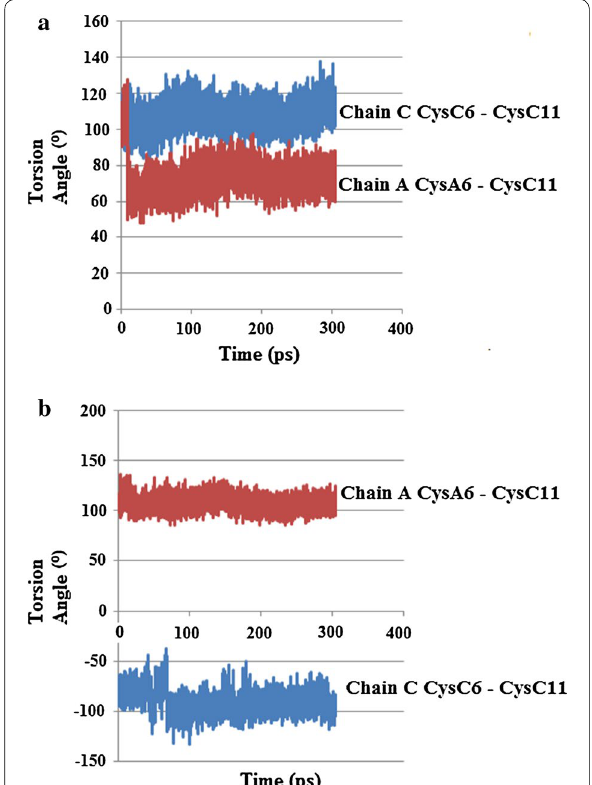
Fig. 20 a Plot of torsion angle χ3 changes for Cys6–Cys11 showing changes for the major conformation of HR insulin, Insugen (I) for the MD simulation carried out at 310 K. b Plot of torsion angle χ3 changes for Cys6–Cys11 showing changes for the minor conformation of HR insulin, Insugen (I) for the MD simulation carried out at 310